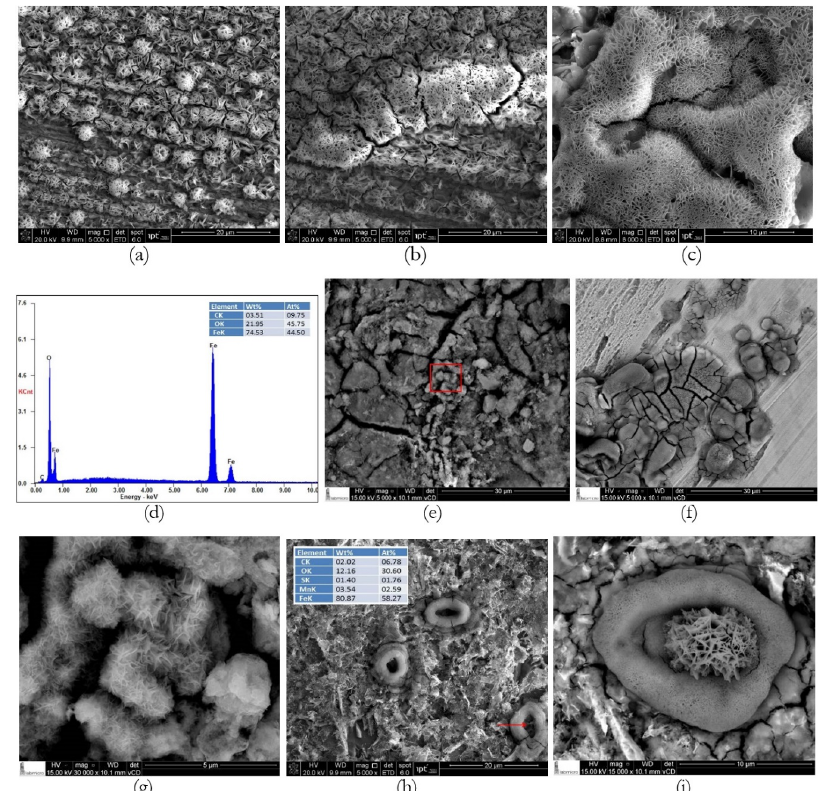
Figure 5. SEM images from the surface of CA-50 steel after anodic polarization. (a) and (b) “AP1 + 1.0% NaCl”, lepidocrocrite (γ -FeOOH) with “birds nest” morphology. Increase of 5000 X. (c) “AP2 + 1.0% NaCl”, lepidocrocyte formation (γ -FeOOH). Increase of 8000 X. (d) EDS spectrum of the region showed in figure (a) . Formation of amorphous structures with dry mud morphology (cracks) in (e) “AP1 + 1.0% NaCl” and (f) “AP2 + 1.0% NaCl”. (g) Enlargement of the region showed in (e), with goethite formation (α -FeOOH). (h) Donut-shaped structures (Fe 3 O 4 ) present on the surface, with EDS result for a specific donut (indicated in the figure). (i) Donut- shaped structure with lepidocrite (γ -FeOOH). Source: Results obtained by Laboratório de Corrosão e Proteção / IPT and Laboratório de Microscopia Eletrônica de Varredura / PMT /